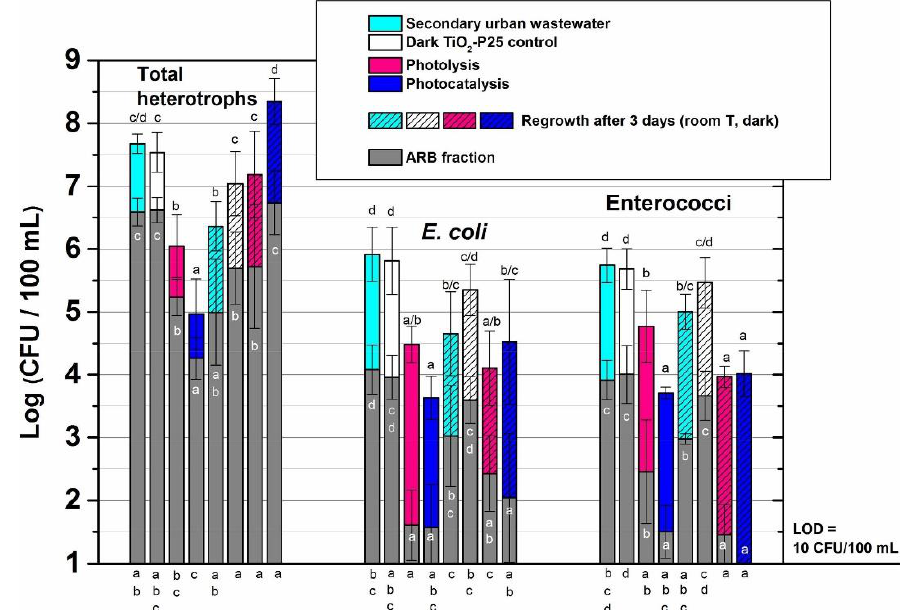
Figure 9. Total (colored) and antibiotic resistant (grey) bacteria inactivation after 1 h photolysis / photocatalysis evaluated immediately (filled bars) and after three days of storage in the dark at room temperature (striped bars). The letters a, b, c, d, and e indicate significantly ( p < 0.05) di ff erent groups among the tested treatment conditions. The letters in black on the top of bars refer to total bacteria. The letters in white refer to the antibiotic resistant counterparts. The letters on the bottom of the graph refer to the percentage of resistant bacteria with respect to the total bacteria. Reprinted with permission from [65], copyright 2019, Elsevier .